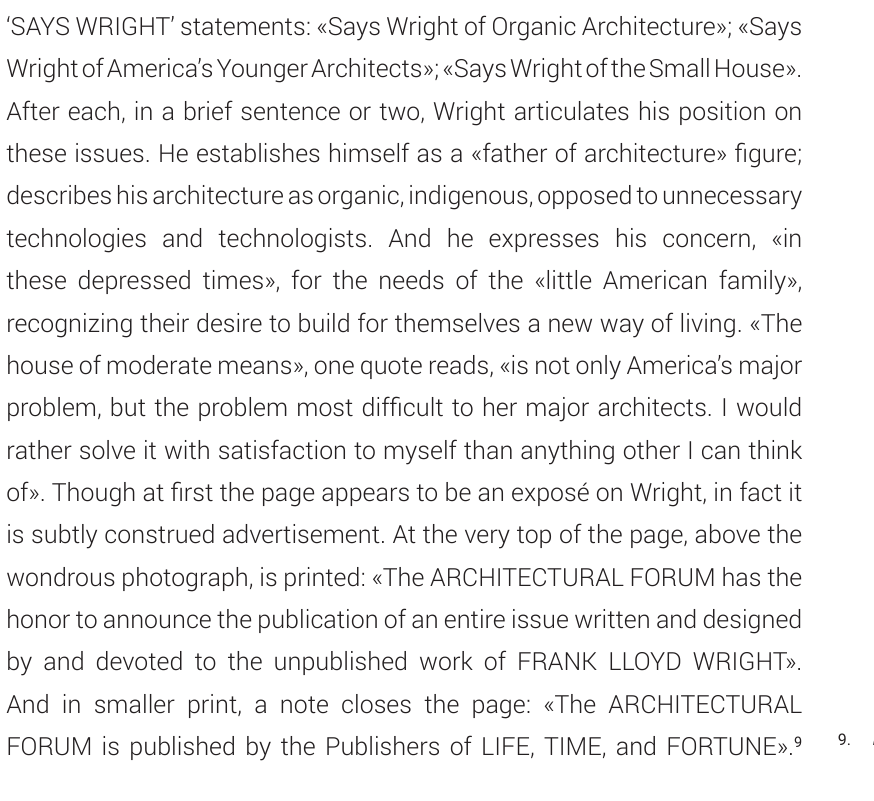
The inside cover of “Life”, vol. FIG. 4 The cover of “Life”, vol. IV, 17 IV, 17 January 1938, No. 3.